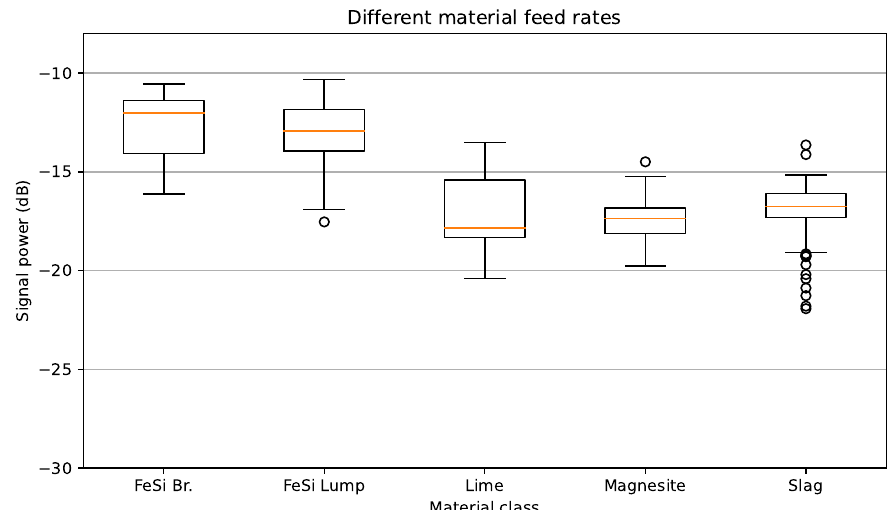
Figure 3. Variability of the dataset: Different material feed rates and classes.